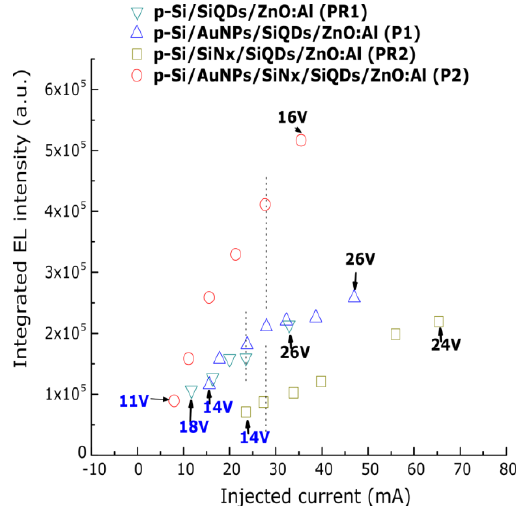
Figure 6. Integrated EL intensity vs injected current (mA) of the samples P1, PR1, P2, and PR2. A maximum EL enhancement (considered as the ratio of integrated EL intensity of devices with gold nanoparticles and reference devices) of 4.7 at ~27.7 mA is found for the P2 sample when compared to the reference PR2